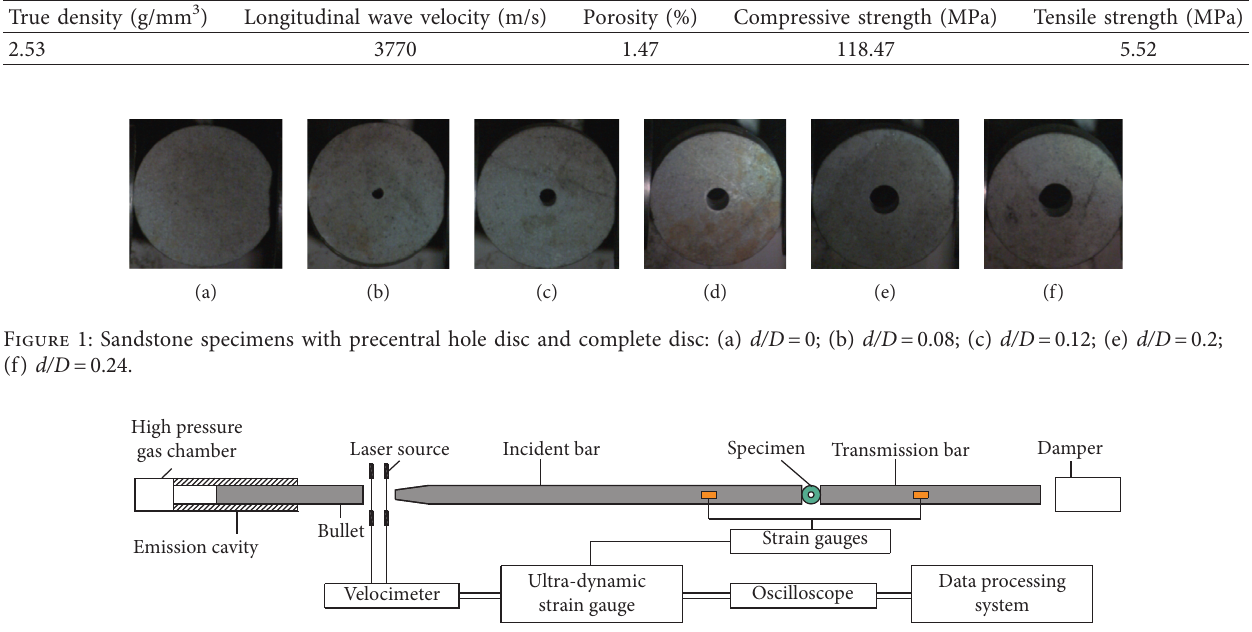
Figure 2: Schematic diagram of the SHPB test